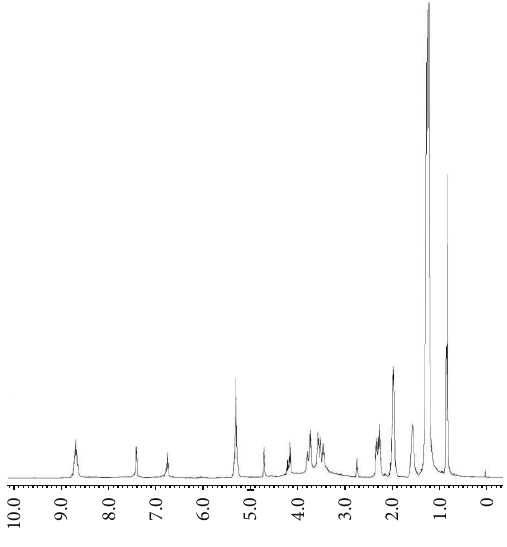
Figure 3: 1 H NMR spectra of PEAF.